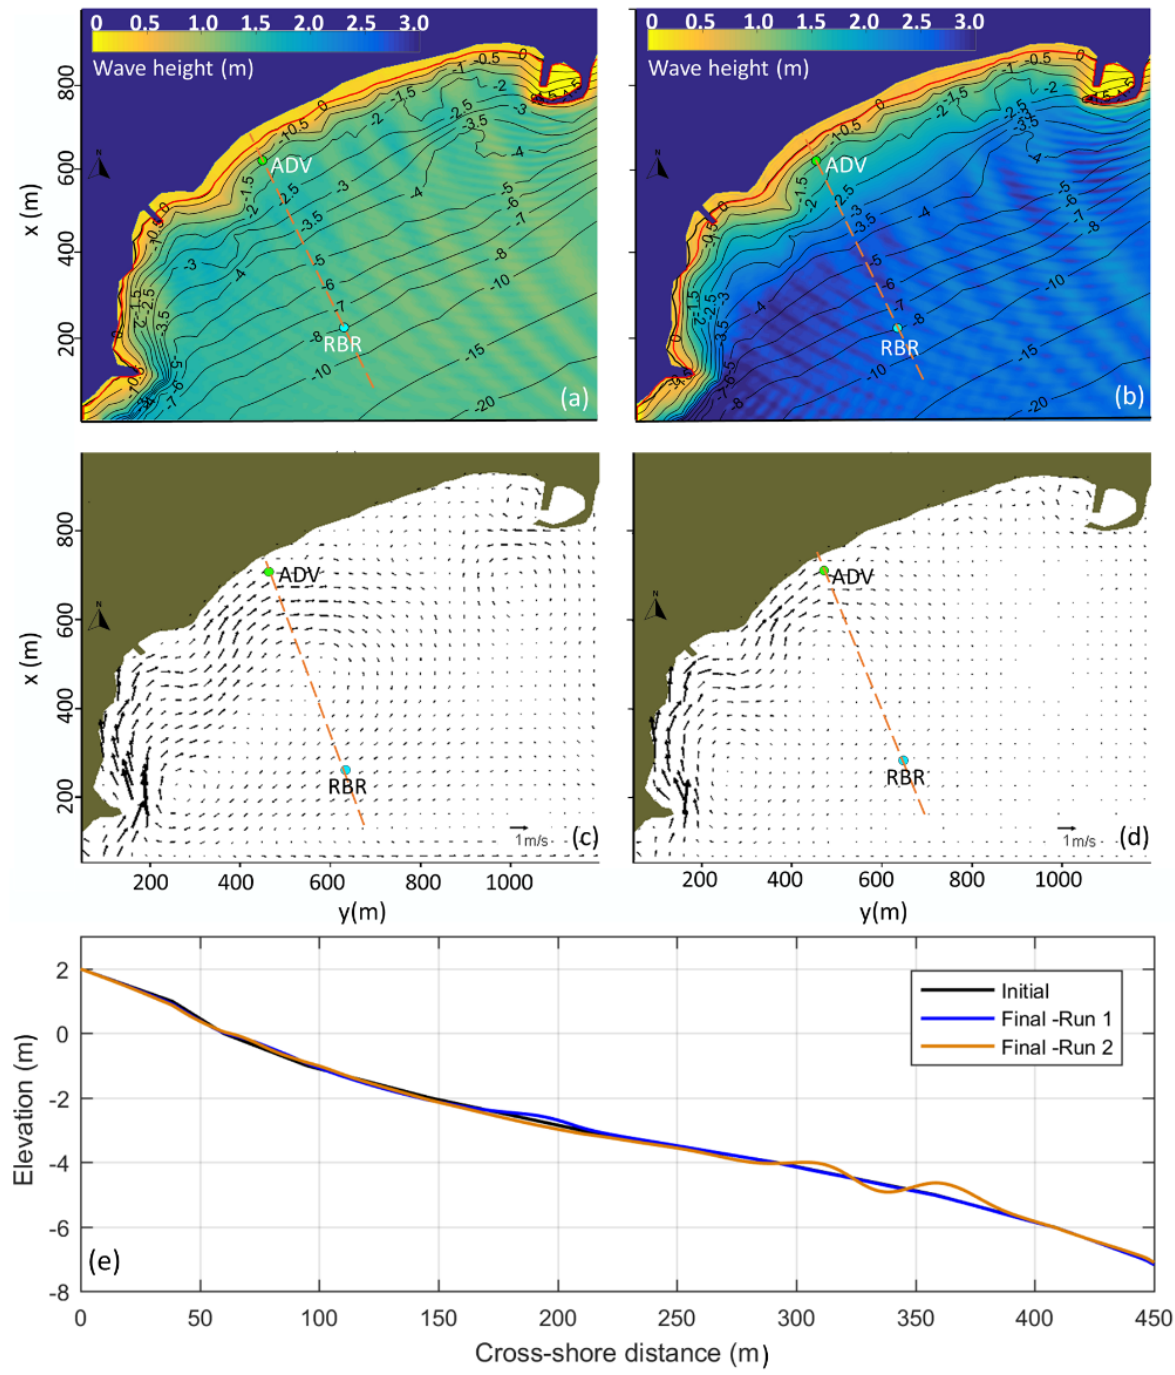
Figure 7. Hydrodynamic model output. Wave height propagation and current circulation driven by the considered wave conditions: ( a , c ) Hs—1.4 m, Tp—6.0 s; ( b , d ) Hs—2.5 m, Tp—6.6 s. ( e ) Bed morphological changes along a cross-shore profile (location at panels a–d) projected from the morphodynamic simulations.